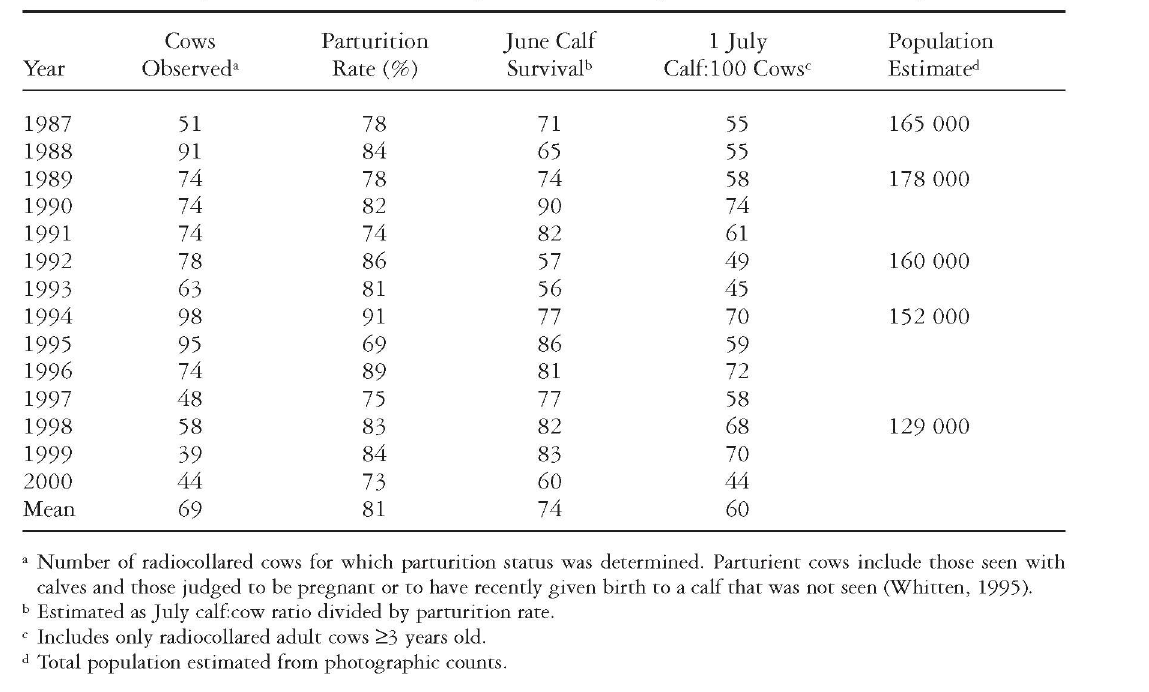
Table 1. Summary of demographic data for the Porcupine Caribou Herd, 1987-2000. Data are from Fancy et al. (1994), Alaska Department of Fish and Game (unpubl.) and Yukon Department of Environment